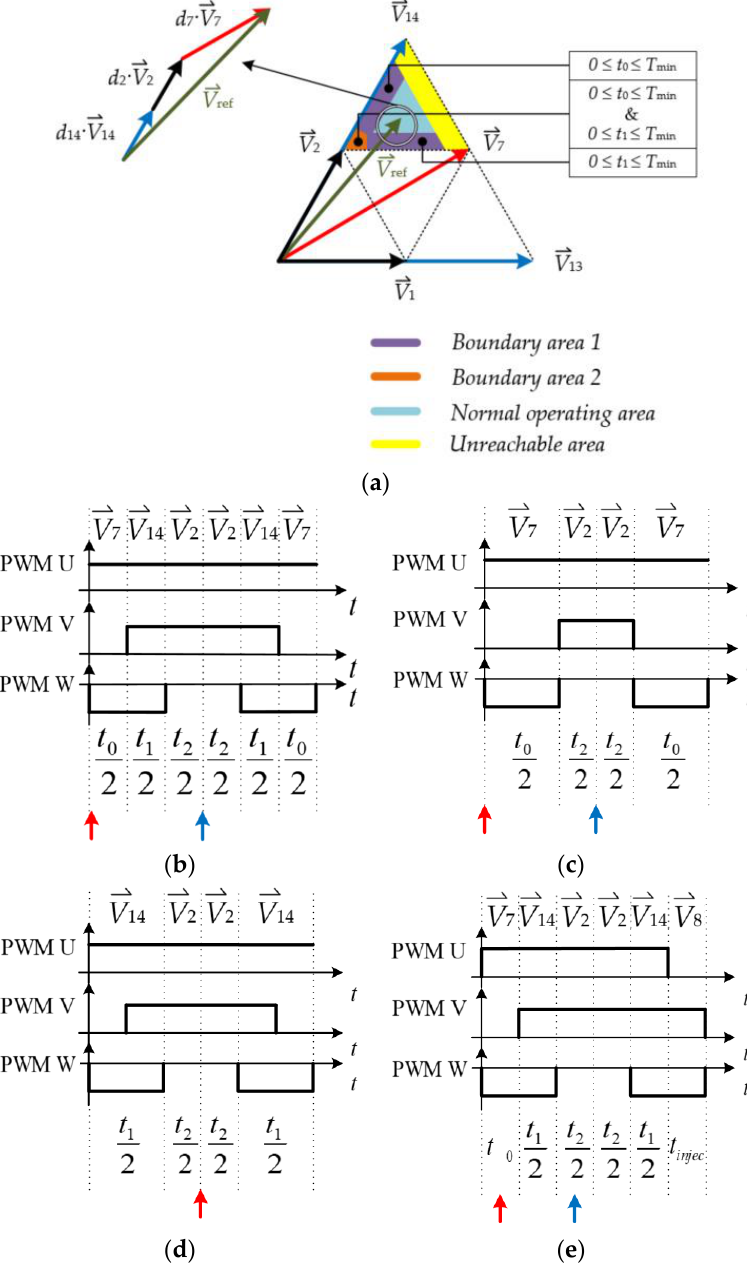
Figure 12. ( a ) Vector diagram for Sector 1 and Region 4 with marked problematic areas for single- shunt measurement; ( b ) SVM pattern for Sector 1 and Region 4 inside the normal operating area; ( c ) SVM pattern while t 1 = 0 s; ( d ) SVM pattern while t 0 = 0 s; ( e ) proposed SVM modification pattern while t 0 < T min .